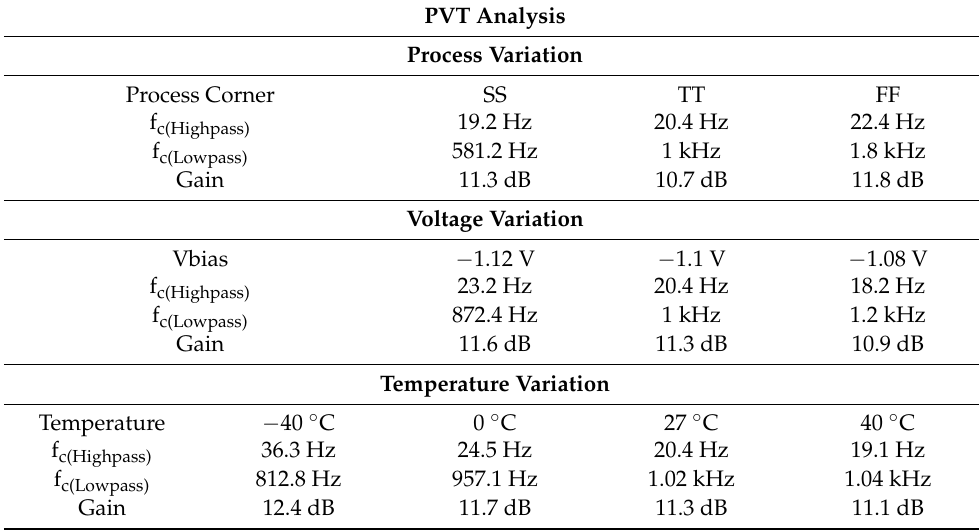
Table 18. PVT corner analysis of low cut-off and high cut-off frequencies of the bandpass